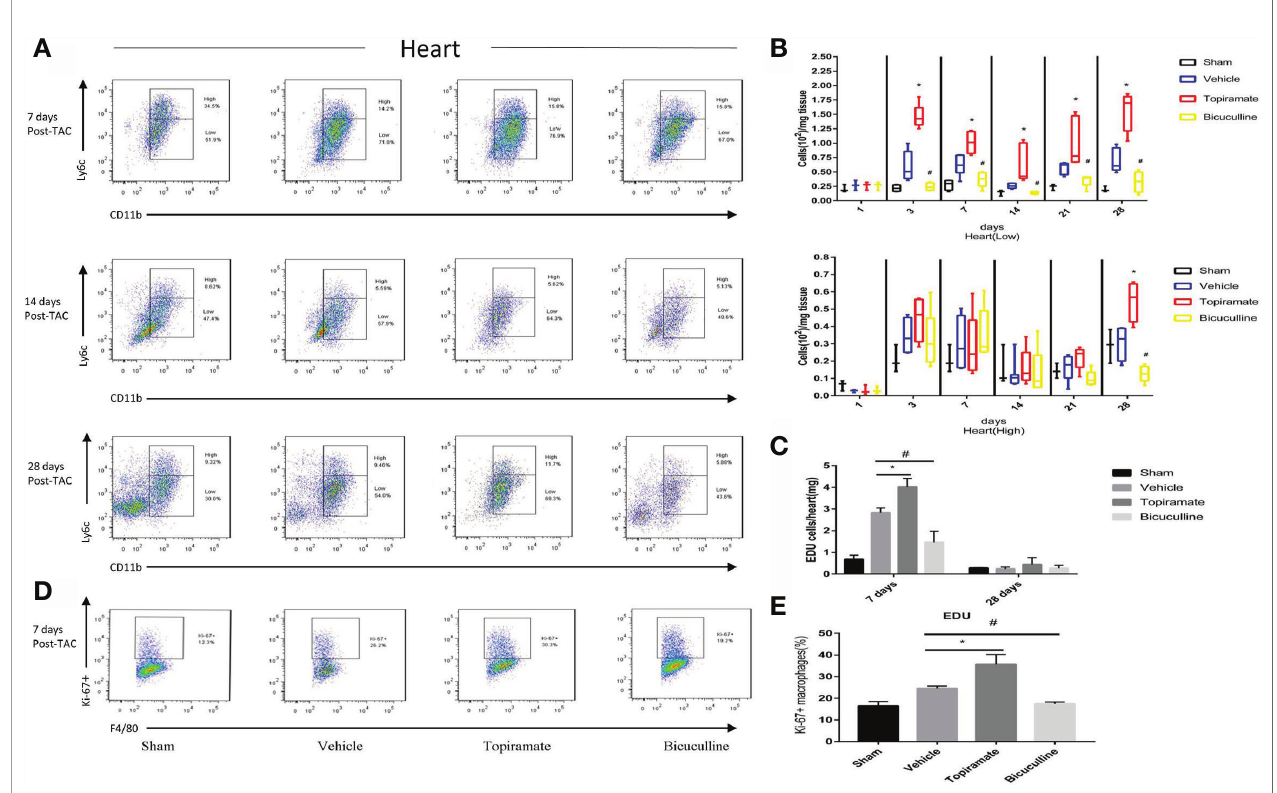
FIGURE 3 | Activation or blockade of the GABA A receptor selectively increases or reduces the number of Ly6C low macrophages in the hearts of pressure-overload hypertrophy mice. Macrophage (CD45 + F4/80 + CD11b + ) subpopulations were respectively de fi ned as Ly6C high or Ly6C low macrophages according to Ly-6C expression levels. (A) Representative images of Ly6C high and Ly6C low macrophages at days 7, 14, and 28 post-TAC. The representative images of 1, 3, and 21 days after TAC were shown in supplementary materials. (B) The number of Ly6C low macrophages or Ly6C high macrophages (per mg heart tissue) among the total number of live cells isolated from hearts at the indicated time points after TAC. (C) The number of CD45 + CD11b + F4/80 + EdU + cell (per mg heart tissue) among the total number of live cells isolated from hearts at the indicated time points after TAC. (D) Representative images of Ki-67 + expression in Ly6C low macrophages at day 7 post-TAC. (E) The percentage of Ki-67 + expression in Ly6C low macrophages. Data show the mean ± SEM, by one-way ANOVA with Bonferroni ’ s multiple comparison test. For topiramate treatment, *P < 0.05 vs. vehicle. For bicuculline treatment, # P < 0.05 vs. vehicle. (n = 3 mice for sham group, n = 6 – 8 mice for all other